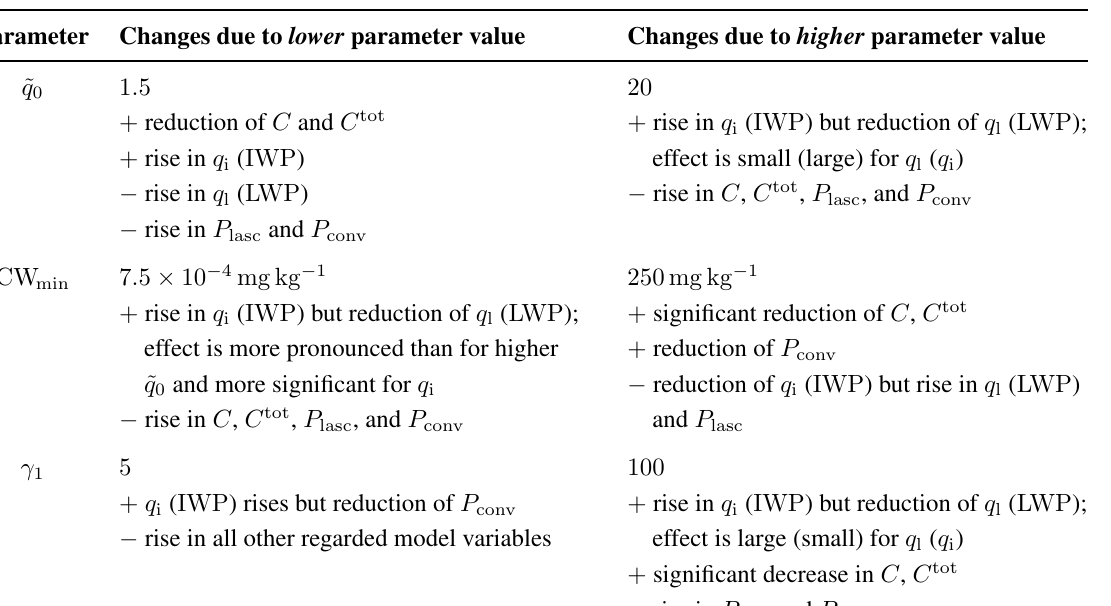
Table 6. Overall effect on cloud-related model variables due to modification of a single model tuning parameter enabling the reduction of C tot relative to the default parameter